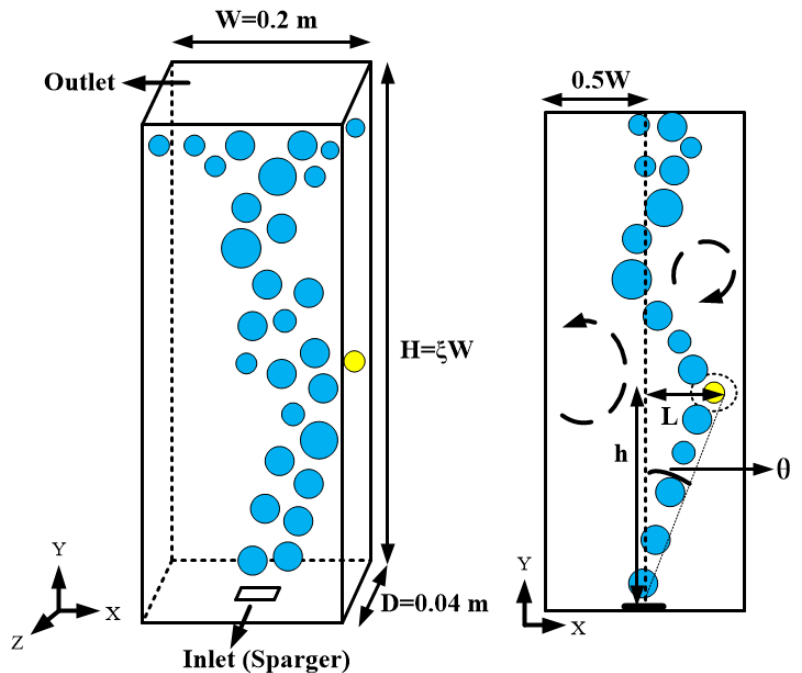
Figure 1. Schematic of the column geometry: (left) 3D representation and (right) 2D view. Table 4. Details of the partial working conditions adopted in the simulation cases.